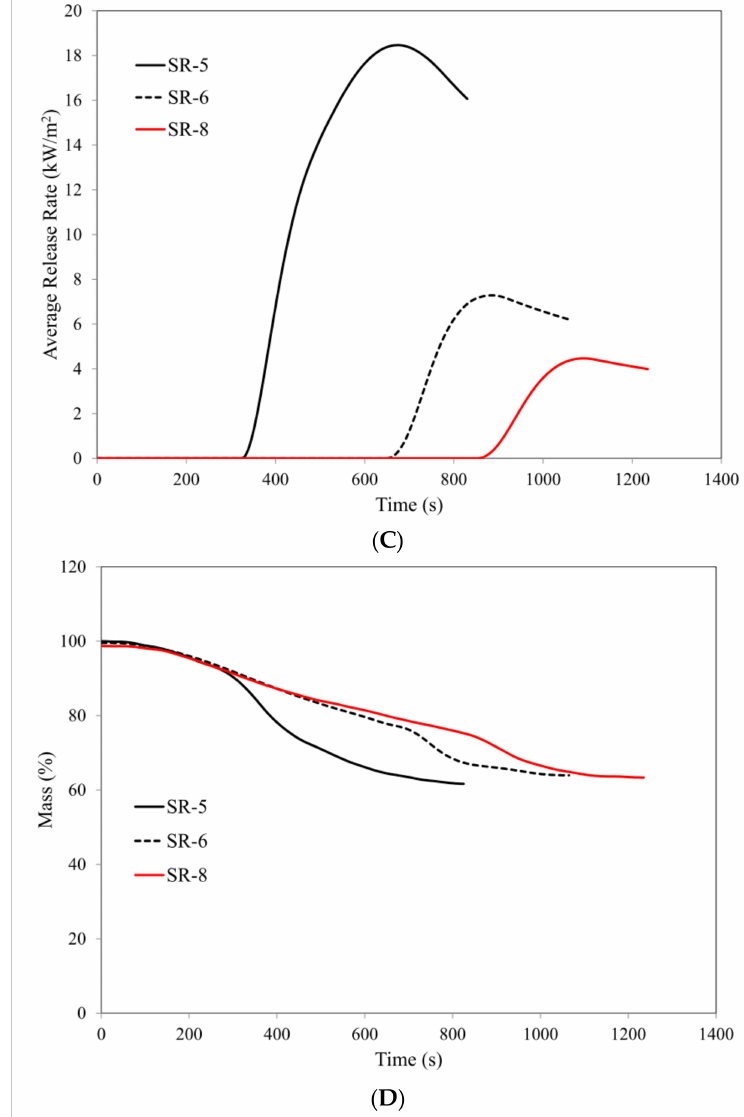
Figure 9. Cone calorimetry analysis: ( A ) max heat release rate, ( B ) total heat released, ( C ) average release rate (ARHE), ( D ) mass loss.